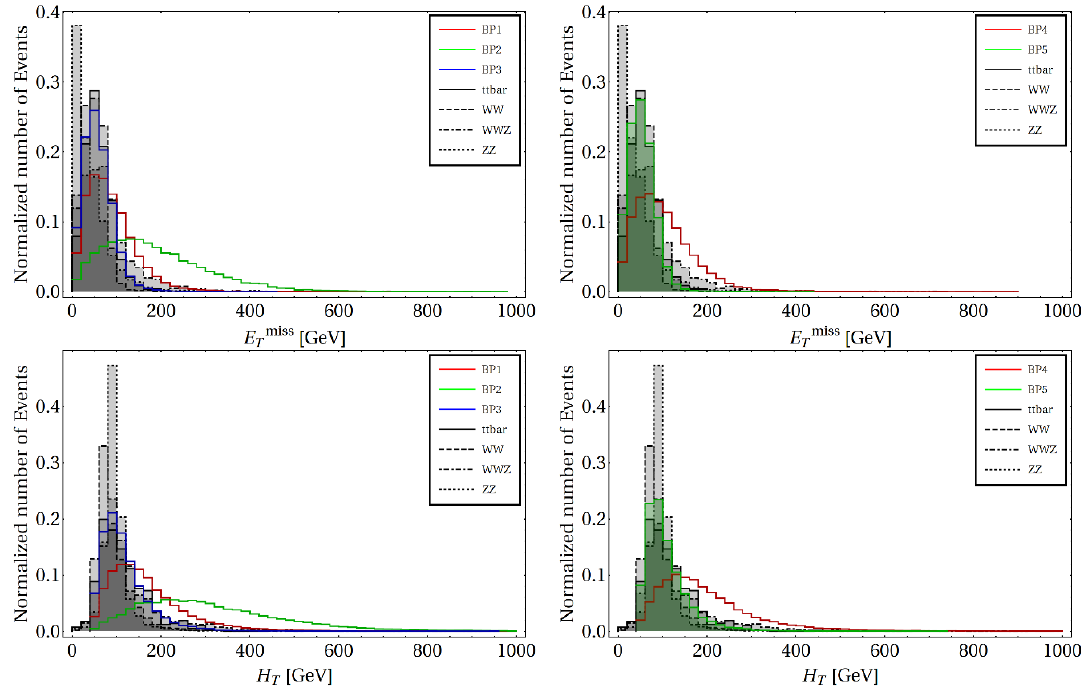
Figure 13 . Top left: distribution of normalized number of signal and background events with MET for BP(1,2,3). Top right: same as top left for BP(4,5). Bottom left: distribution of normalized number of events with H T for BP(1,2,3). Bottom Right: same as bottom left for BP(4,5). All p simulations are done at s = 14 TeV.